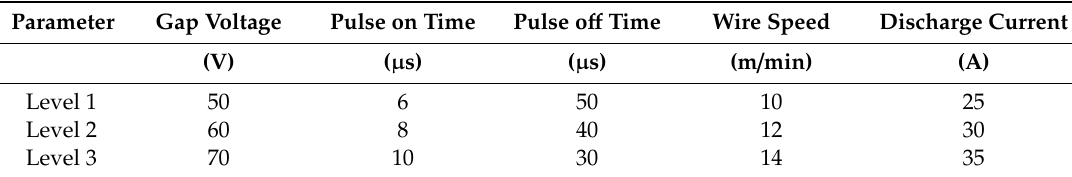
Table 2. Limit values of machine setting